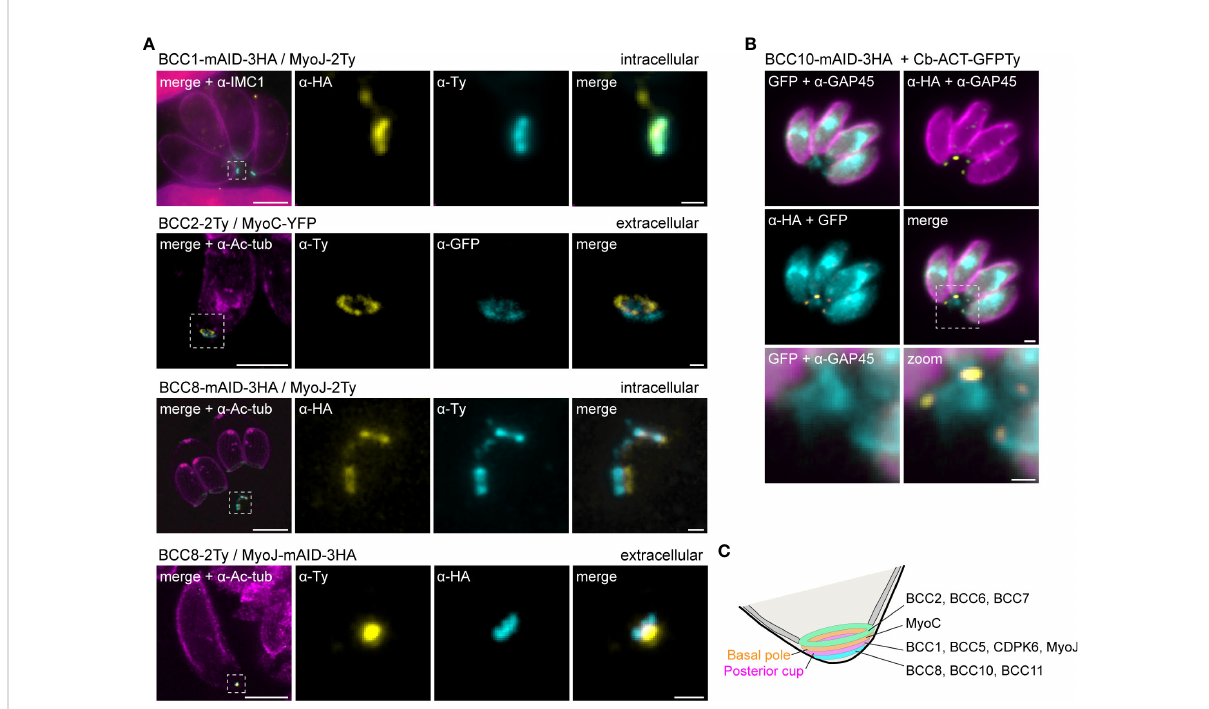
FIGURE 5 The basal complex is organized in four ring-shaped structures. (A) Co-staining of BCC1, BCC2, and BCC8 with endogenously tagged MyoJ or MyoC con fi rms their localization into the basal complex. BCC1 co-localizes with MyoJ at the posterior cup, while and BCC2 is located in a new sub-compartment above the basal ring (MyoC staining). Finally, co-labeling of BCC8 in a MyoJ-tagged strain corroborates the presence of a ring structure under the basal posterior cup that appears highly constricted in extracellular parasites compared to intracellular. Magenta: IMC1 or acetylated tubulin (Ac-tub), Yellow: BCC of interest, Cyan: MyoC or MyoJ. Scale bars: vacuole, 10 m m; zooms, 1 m m. (B) Co-localization of BCC10 within intravacuolar connections marked by F-actin chromobodies (Cb-ACT-GFPTy) and parasite periphery marked by GAP45. Magenta: GAP45, Yellow: BCC10, Cyan: F-actin. Scale bars: vacuole, 2 m m; zooms, 1 m m. (C) Model of the basal pole of the tachyzoite with the location of the BCCs. According to the mapping performed in this study, the basal complex is organized in at least four superimposed ring-shaped sub- compartments. The previously described basal ring and posterior cup are orange and pink,